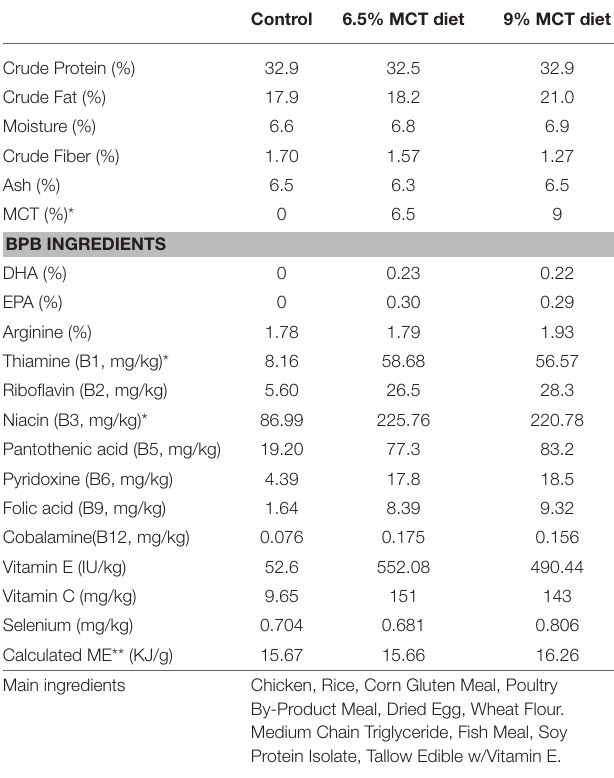
TABLE 1 | Ingredients and chemical composition of diets as